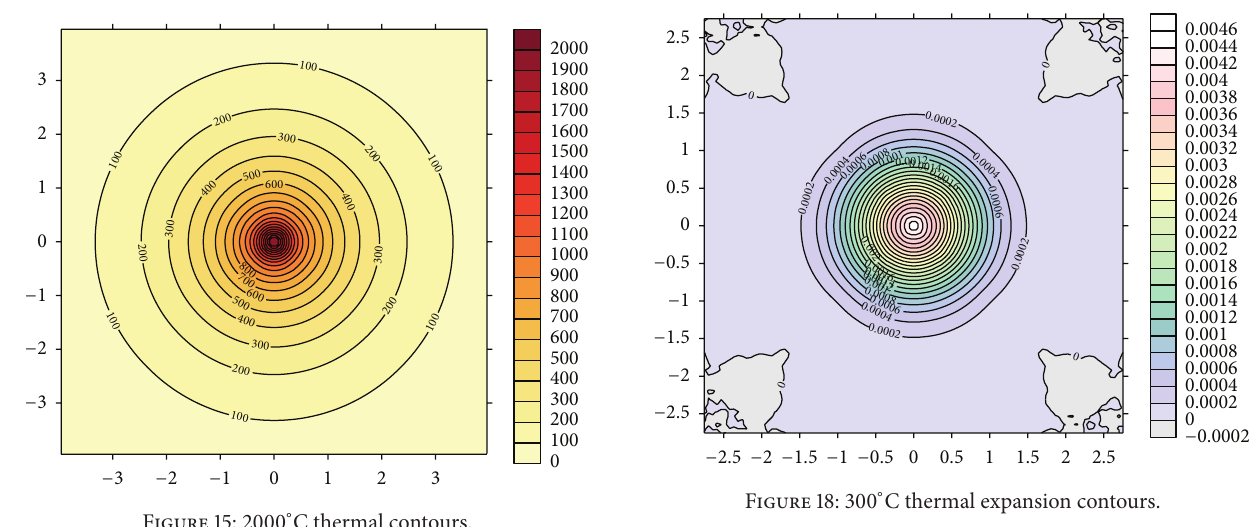
Figure 15: 2000 ∘ C thermal contours.